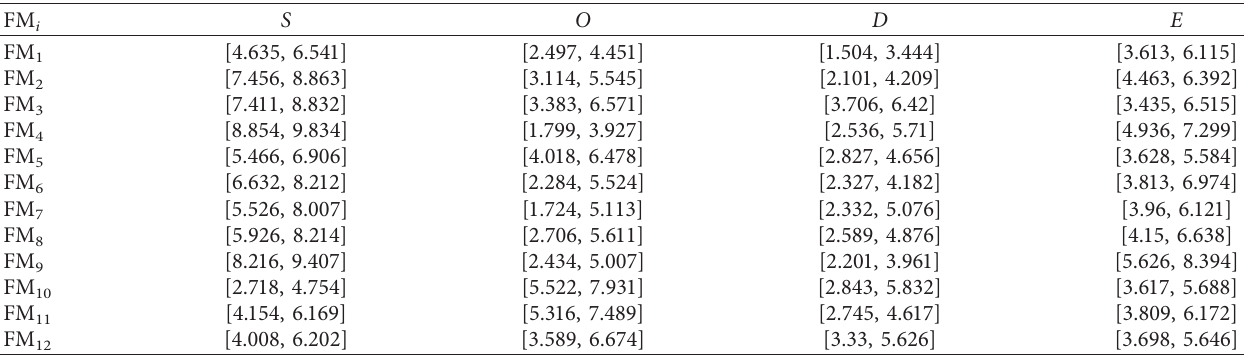
Table 3: Rough assessment matrix.